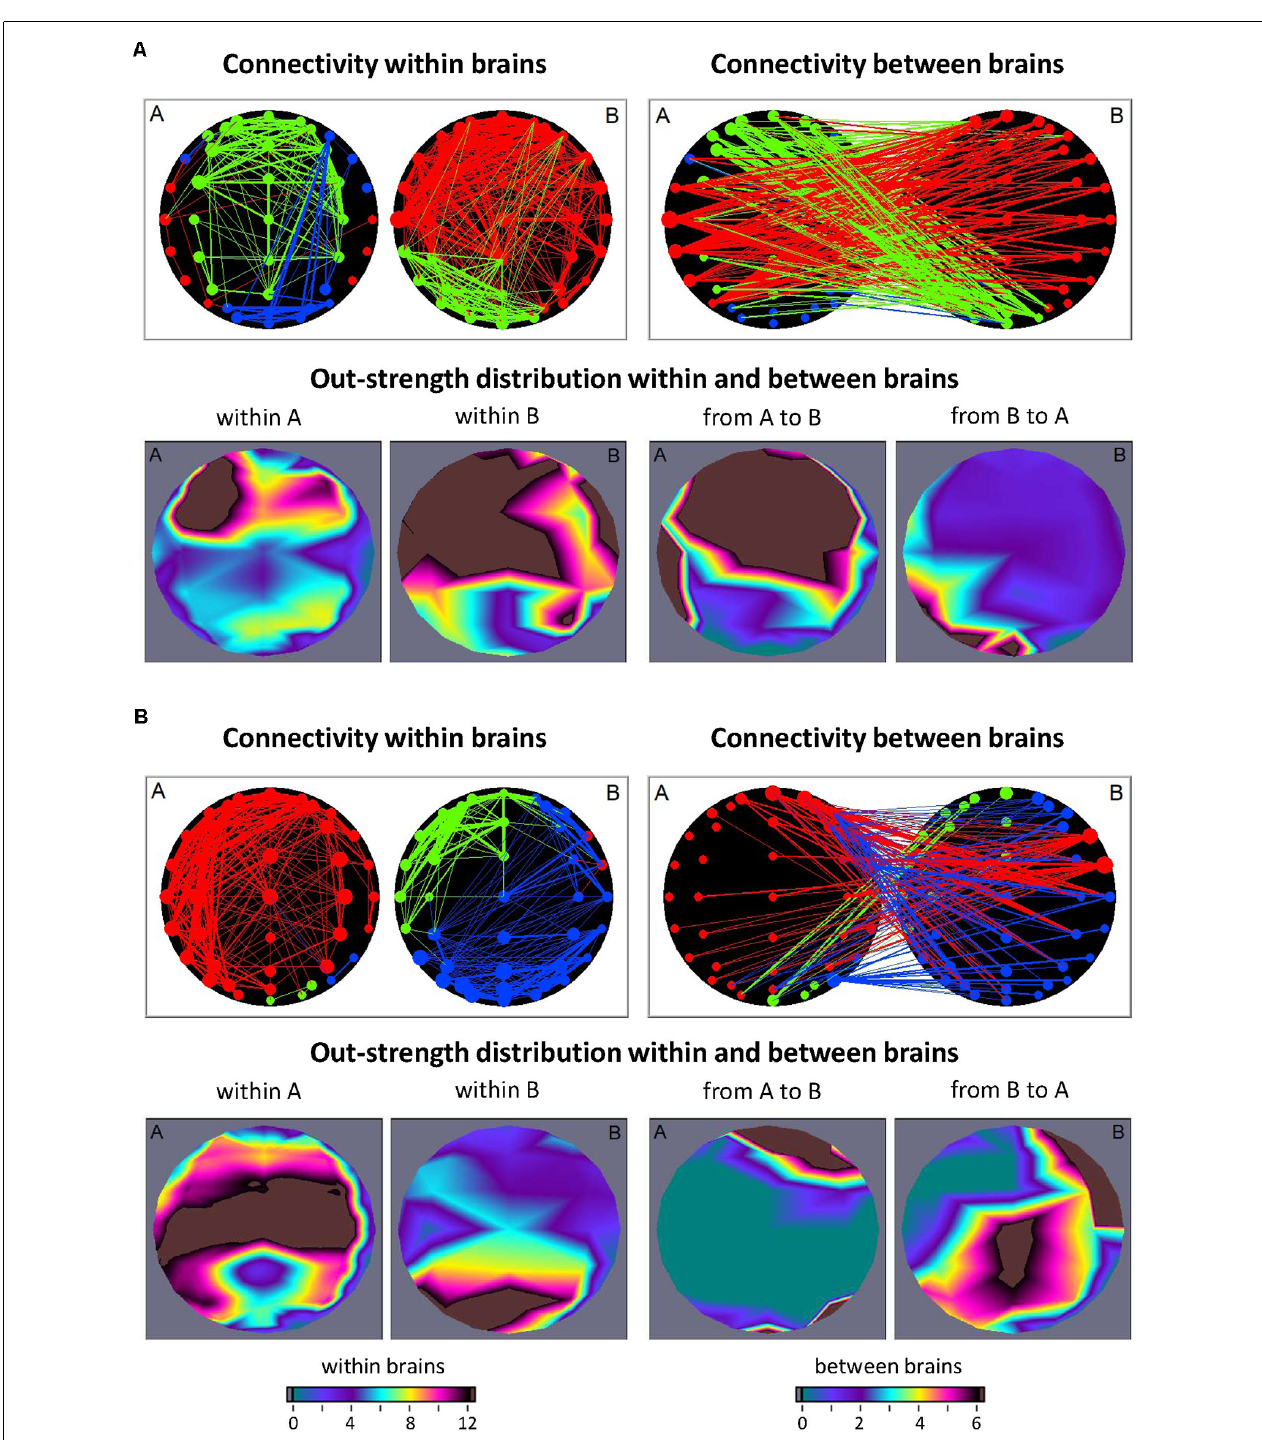
FIGURE 2 | Connectivity within and between the brains and corresponding out-strength distributions during free guitar improvisation. (A) Connectivity maps and out-strength distributions in the first time window. In the first row, the left panel represents the connectivity within the brains, and the right panel represents the connectivity between the brains. The size of the circles represents the strength of the nodes (electrodes) and connectivity strength is coded by line thickness. The three different modules are coded by color. In the second row, the two maps on the left represent the topological distribution of the out-strengths within the brains of the two guitarists, and the right ones display the topological distribution of the out-strengths going from guitarist A’s brain to guitarist B’s brain and vice versa . (B) Connectivity maps and out-strength distributions in the second time window. Connectivity maps within and between the brains and corresponding out-strength distribution maps are represented in the same way as in (A)